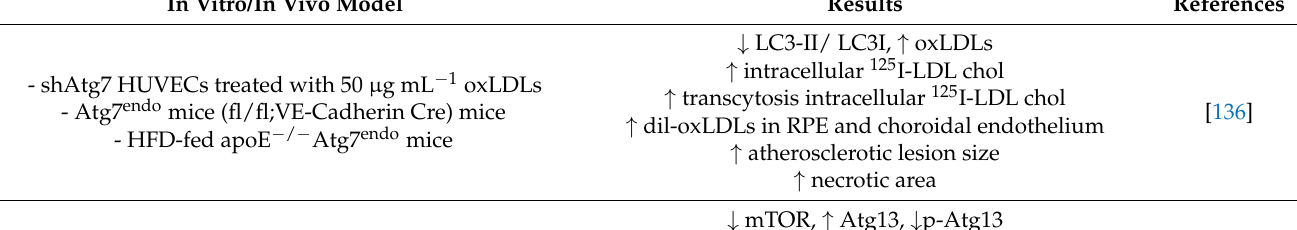
Table 1. Studies on defective autophagy in endothelial cells: role in atherothrombosis. In Vitro/In Vivo Model